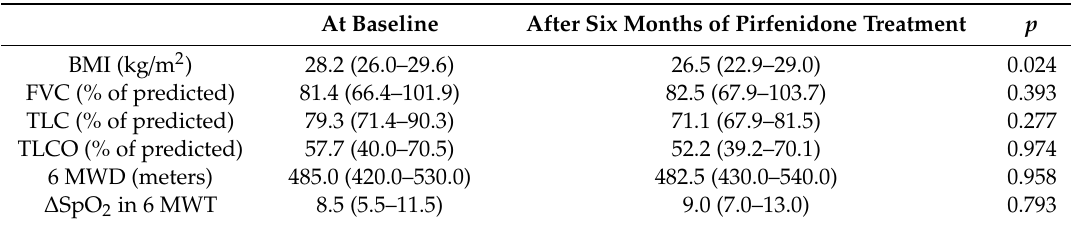
Table 2. Comparison of the basic characteristics of the investigated patients at baseline and after six months of treatment with pirfenidone ( n =